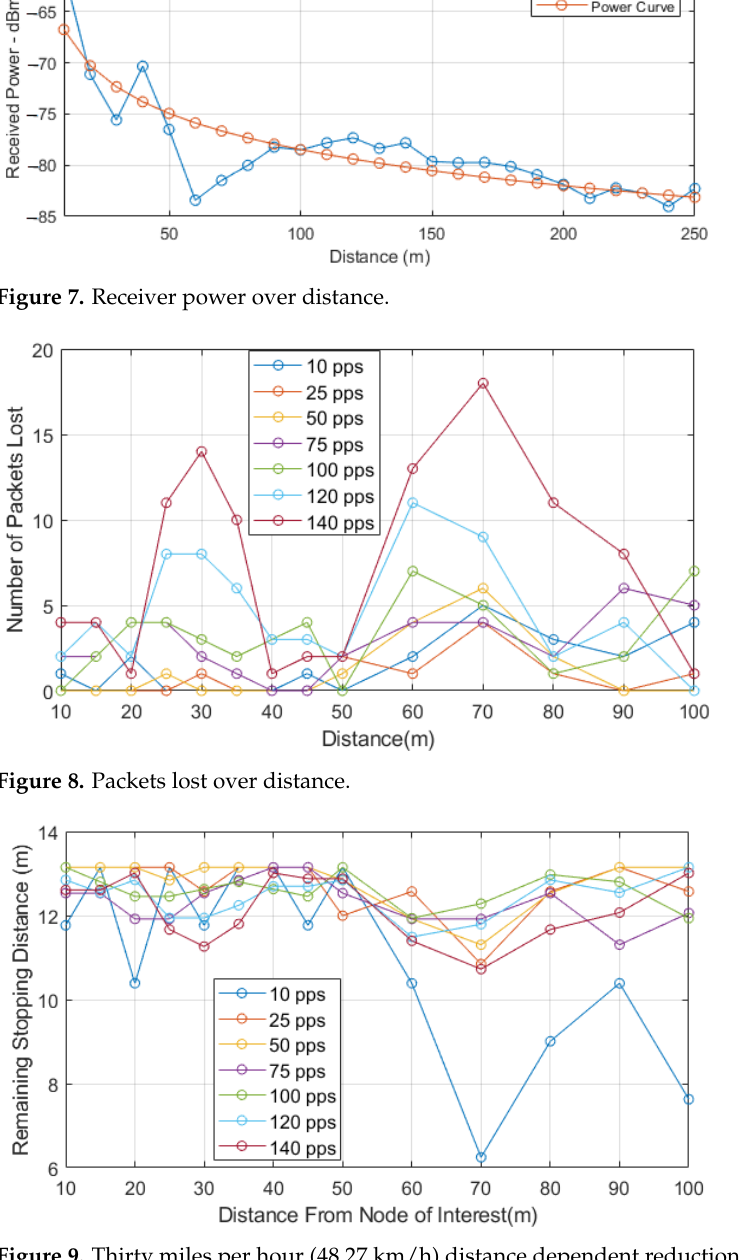
Figure 9. Thirty miles per hour (48.27 km/h) distance dependent reduction in stopping